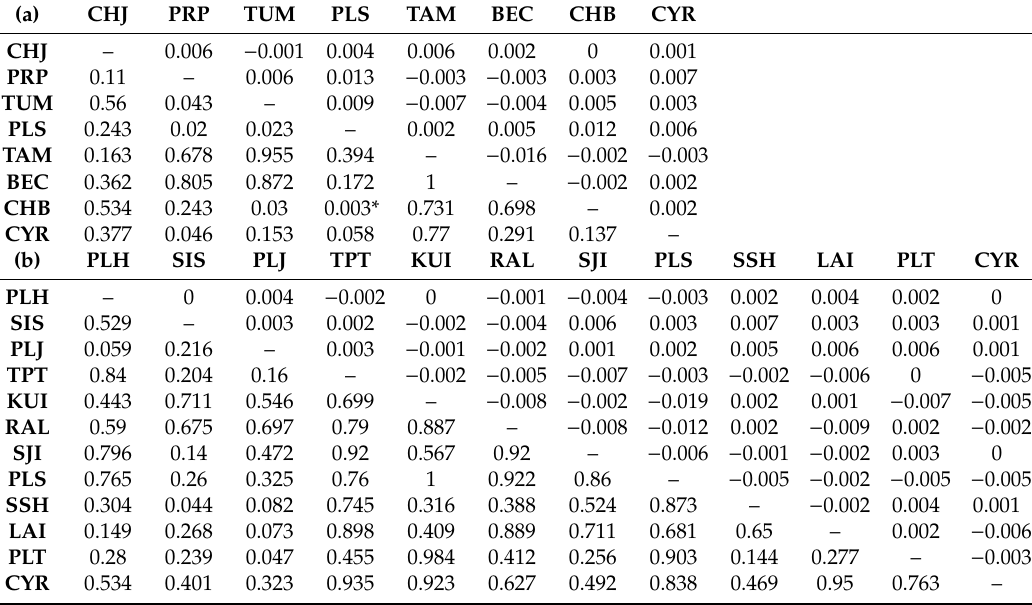
Table 1. Pairwise-comparison of sites and corresponding F ST values (above the diagonal) and p-values (below the diagonal) of ( a ) S. haddoni (sti_b1.10miss) and ( b ) E. quadricolor (ane_b3.10miss). Significant p-values after Bonferroni correction are indicated with an asterisk (*).